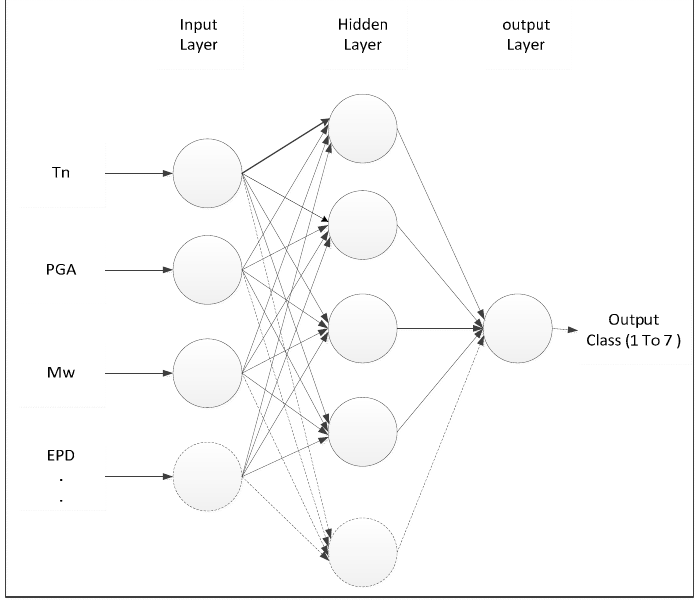
Figure 3. ANN models.